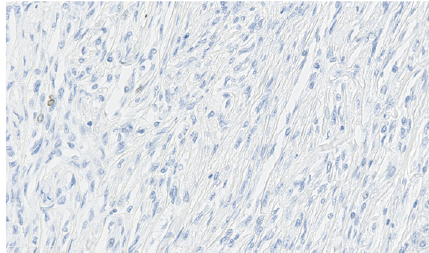
Figure 3: Immunohistochemistry with MIB-1. Approximately 3% of the neoplastic cells stain for MIB-1 by immunohistochemistry (400x).